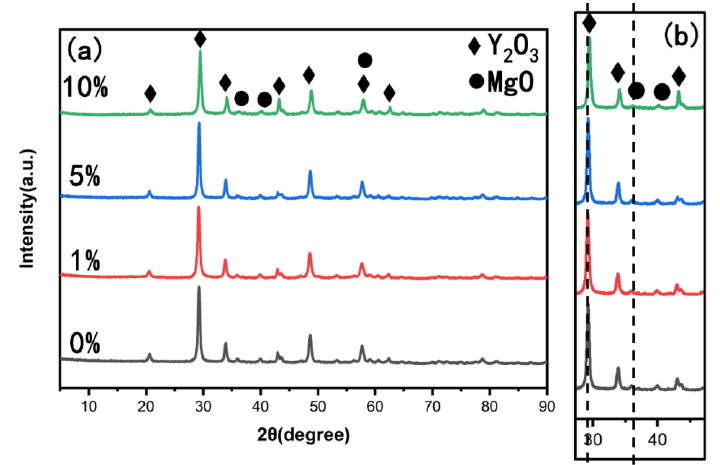
Figure 3. ( a ) X-ray diffraction patterns of powders derived from 230 °C for 2 h with different mass percentages of seed of 0%, 1%, 5% and 10%; ( b ) the details of the XRD patterns between 27° and